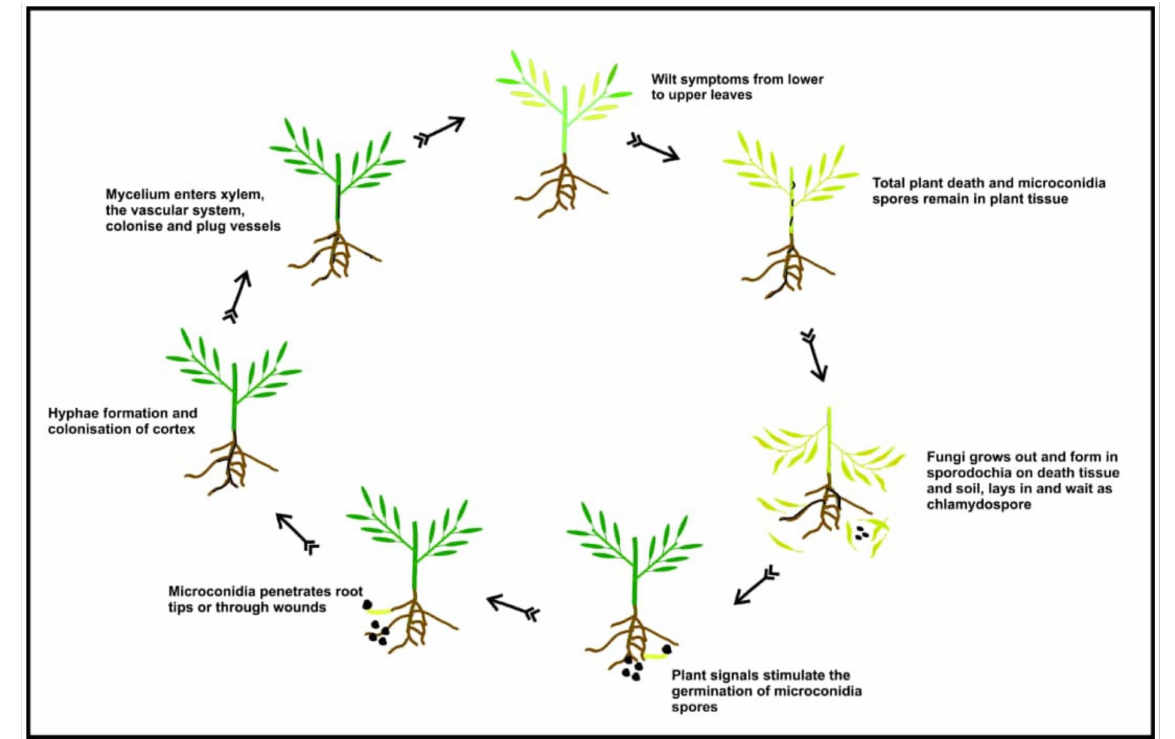
Figure 2. A pictorial presentation of fusarium wilt life